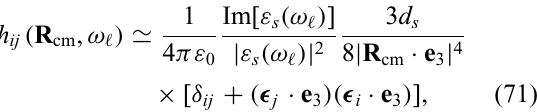
Table I at a trapping frequency ω tion direction (cid:2) (cid:13) (ω ) = q 2 n (ω 0 h